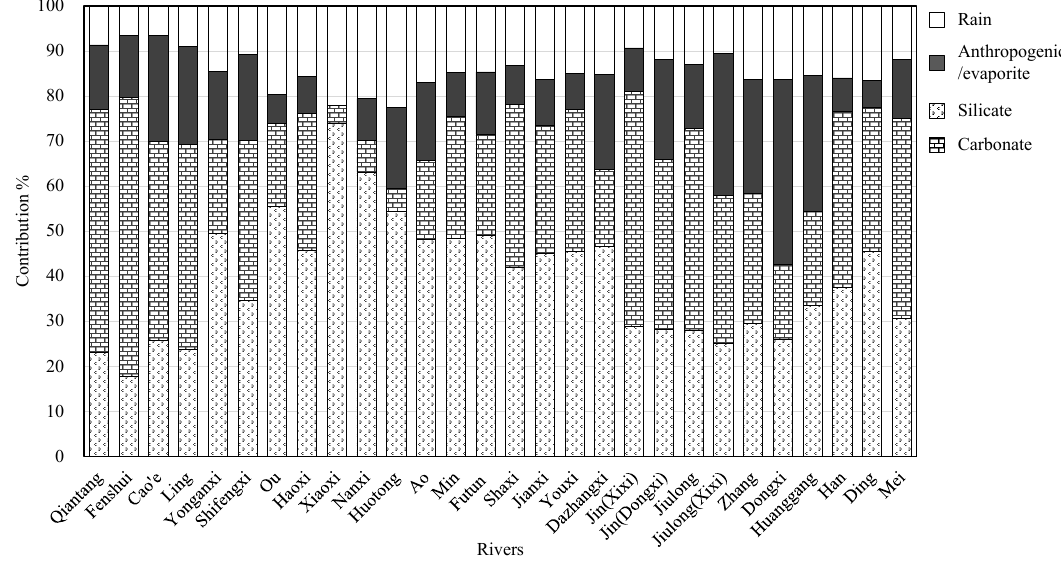
Figure 4. Calculated contributions (in %) from the different reservoirs to the total cationic load for major rivers and their main tributaries in the SECRB. The cationic loads are the sum of Na + , K + , Ca 2 + and Mg 2 + from different